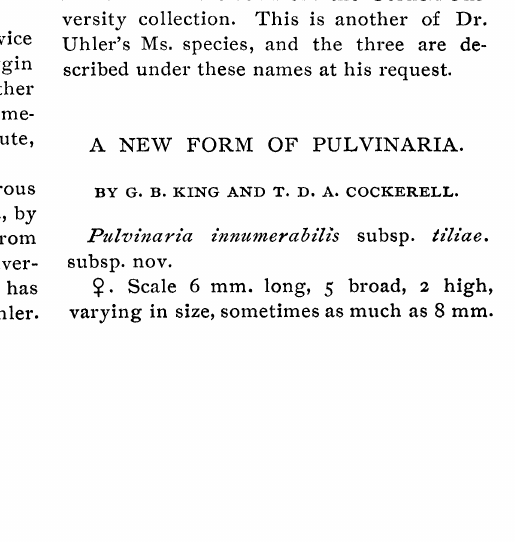
legs inclining to orange, dorsum bright carmine. Front with three longitudinal black lines nearly through- out its length on the disc, two abbreviated dashes above, and two dots on each lateral margin, one at antennal pit, the other at clypeal angle. A transverse row of three black spots on each gena. Clypeus with a dark median line. Front edge of vertex with three black dots, one at center and One on either side. Disc of vertex with a black line on either side, near and mostly parallel with front edge, extending from a short longi- tudinal dash near median line and just back of apex to the frontal suture; basal half of vertex with four equidistant rectangular spots, the two outer including the ocelli, the two inner somewhat elongate. Pronotum pale, slightly tinged with reddish posteriorly, with a row of six rectangular black spots near anterior margin, and a row of four smaller ones near hind margin; disc with four indistinct longitudinal lines.